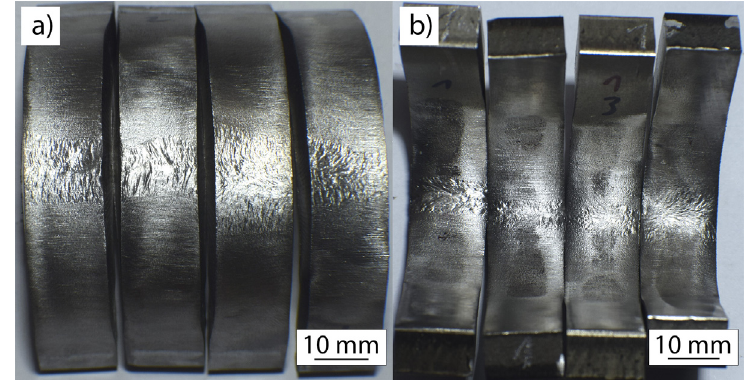
Figure 10. Bend testing of the 1Ti4Si specimen; weld root ( a ) and weld face ( b ).